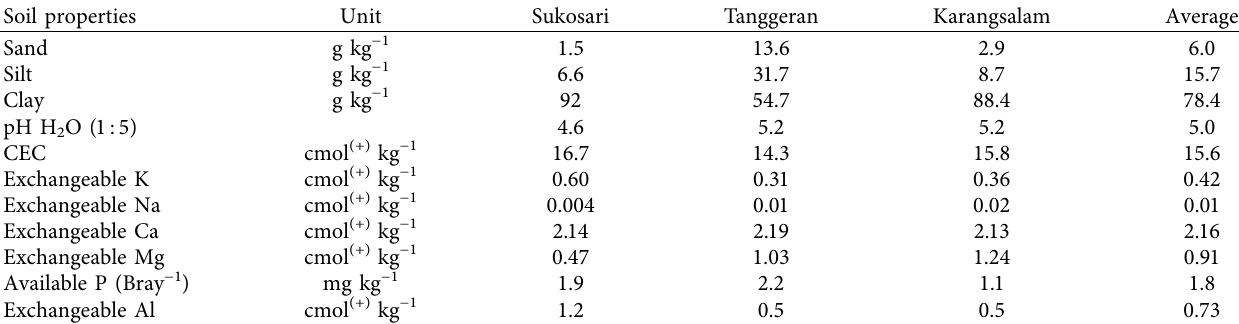
Table 1: Soil properties of the acidic soils of Sukosari, Tanggeran, and Karangsalam, Indonesia. Soil properties